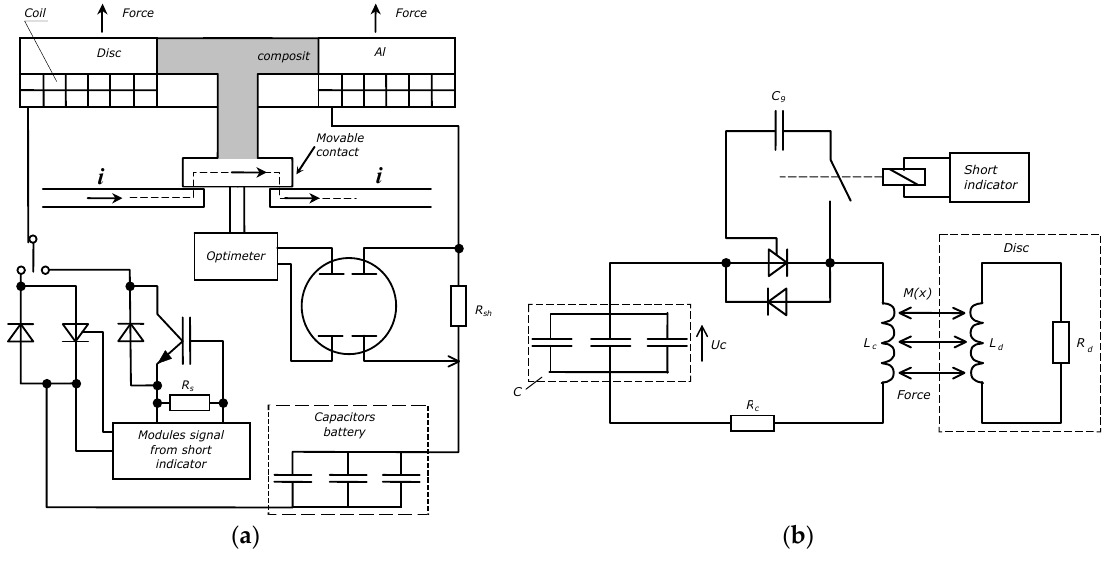
Figure 3. System of IDD ( a ) Measurement scheme ( b ) Electric scheme—simple realization of the gate circuit.